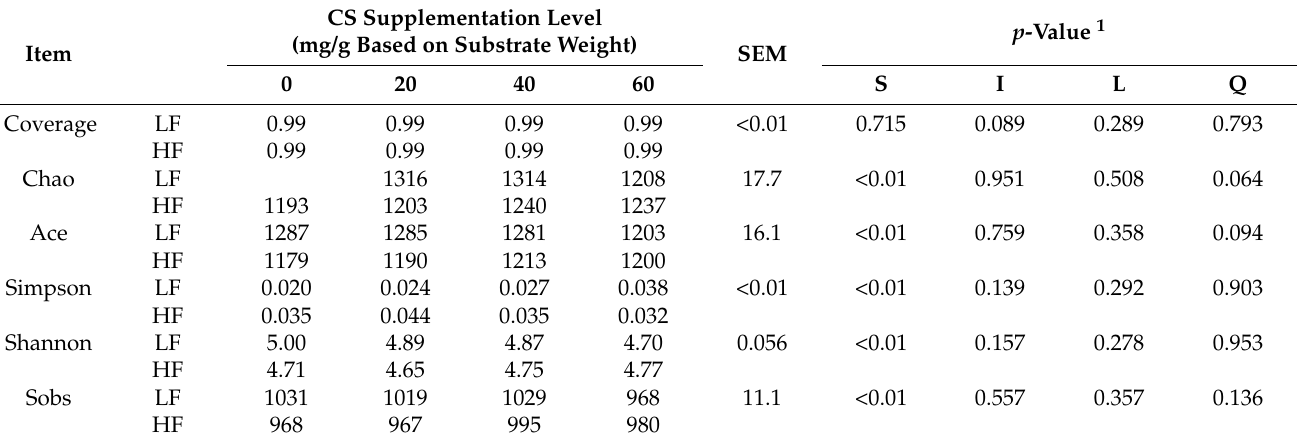
Table 5. Effect of substrates and increasing CS supplementation level on ruminal bacteria alpha diversity based on